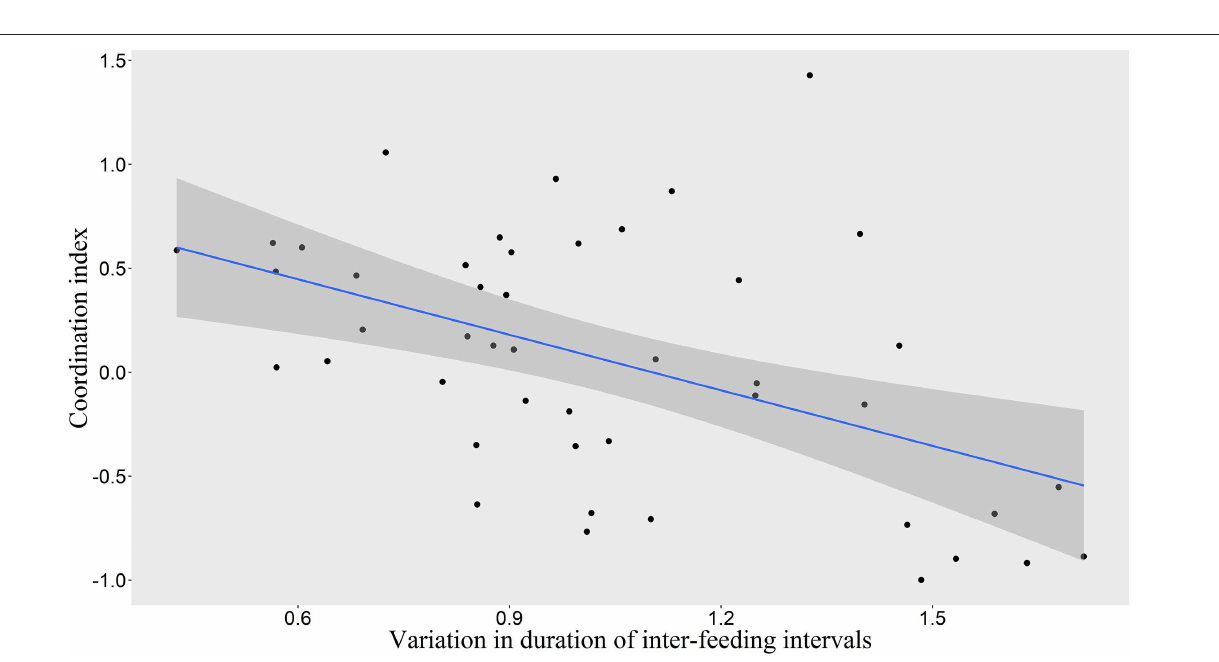
of parental coordination to test potential adaptive value of the coordination. However, we did not find any significant effect, at least within the observed range of environmental